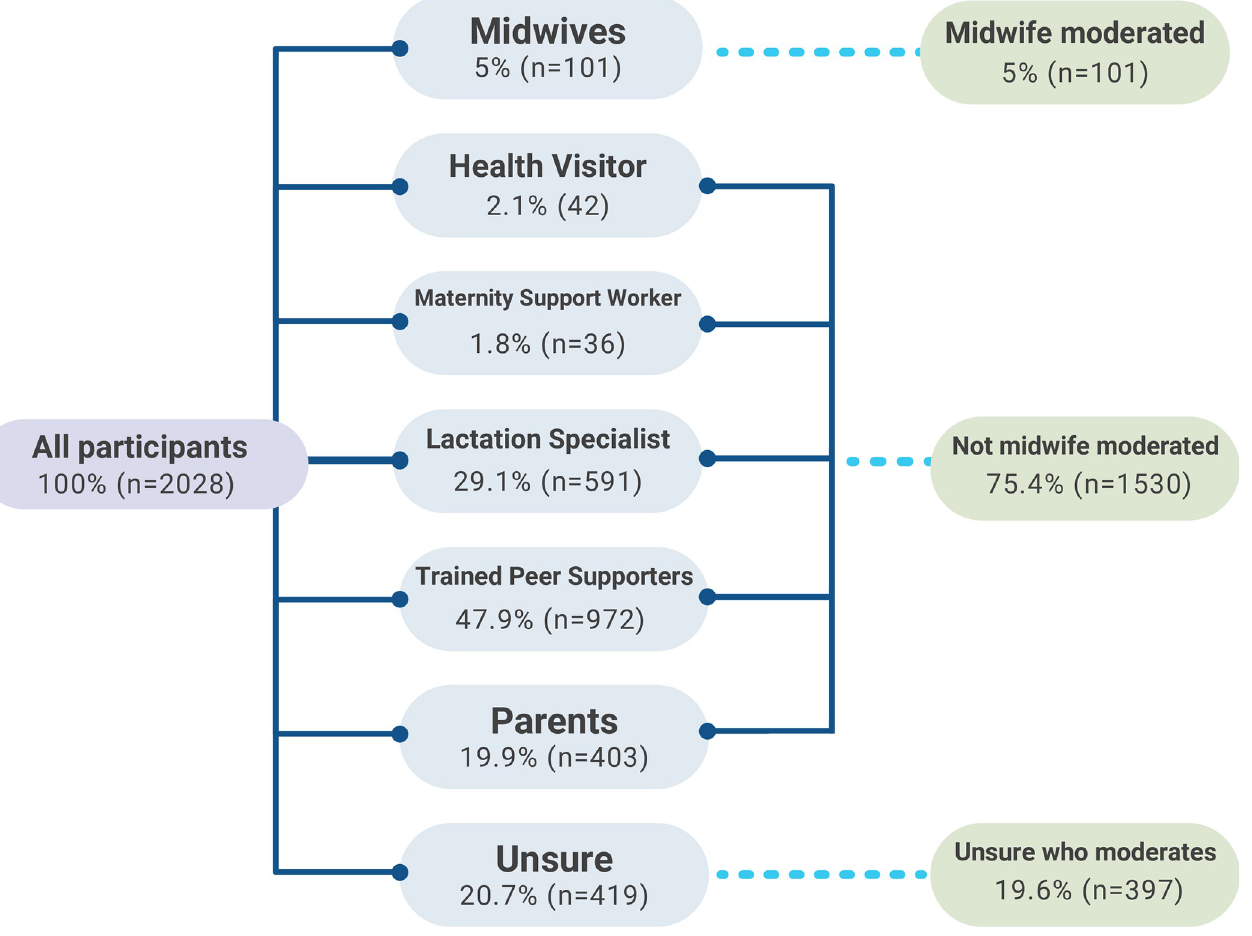
Fig 1. Sample breakdown used for analysis by group